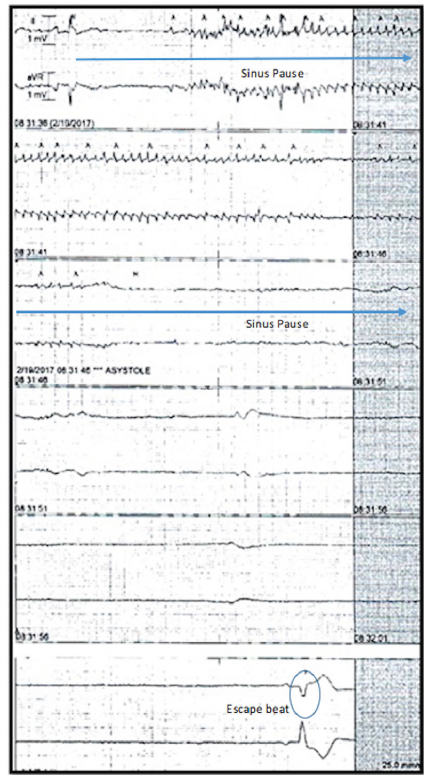
Figure 1: Telemetry recording from the time of syncopal event in our patient demonstrating sinoatrial arrest and a 26-second pause. Notice the absence of any atrial activity during the pause indicating this is sinus pause rather than AV block. The telemetry marks some tremor artifact during the event erroneously as atrial activity (A) which is another important finding to